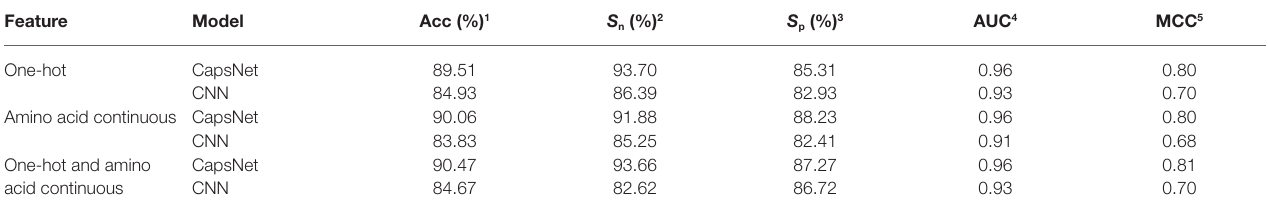
TABLE 3 | Comparison of various coding schemes.